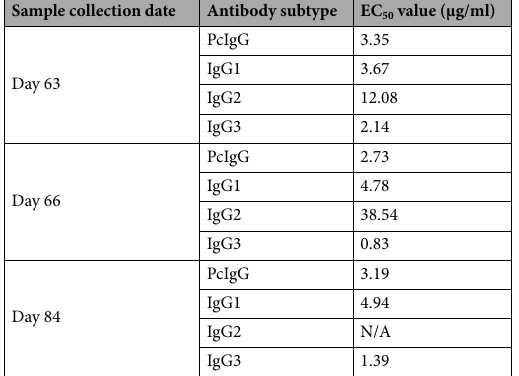
Sample collection